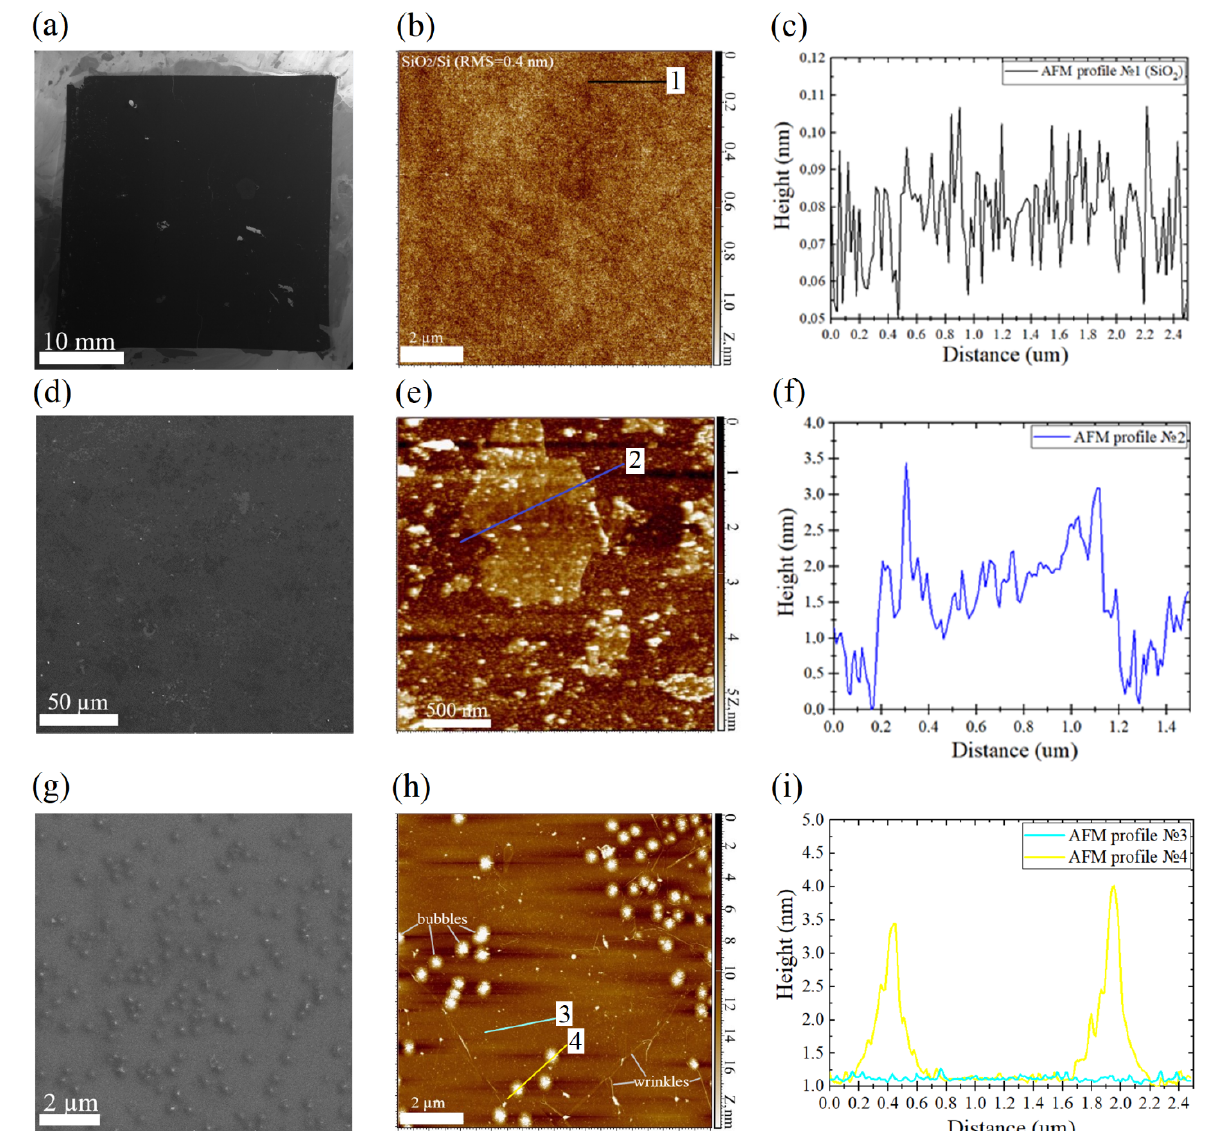
Figure 2. SEM images of graphene layers obtained on a 3-inch silicon wafer (with amorphous surface due to thermal oxide film) via PA-MBE epitaxial growth ( a ). Randomly selected regions of FLG ( d ) and MLG ( g ). AFM height images and line scan profiles: the oxide surface ( b , c ), the random regions of FLG ( e , f ) and MLG ( h , i ).